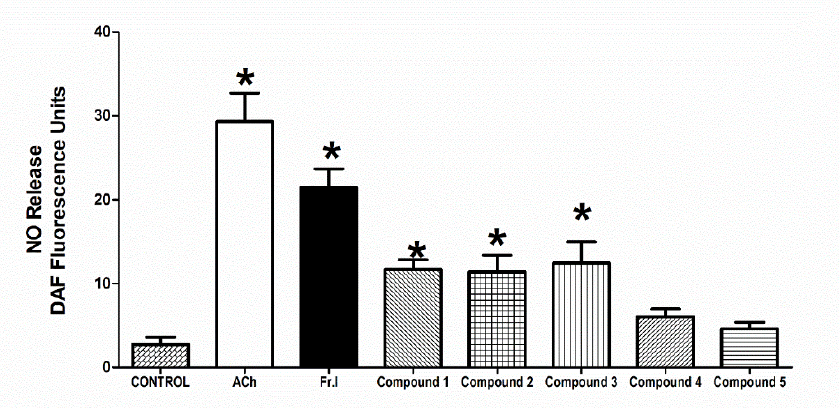
Figure 6. Influence of H. revolutum , 10 µg/mL Fraction I, and compounds 1 – 5 (conc. 10 µM) on vas-